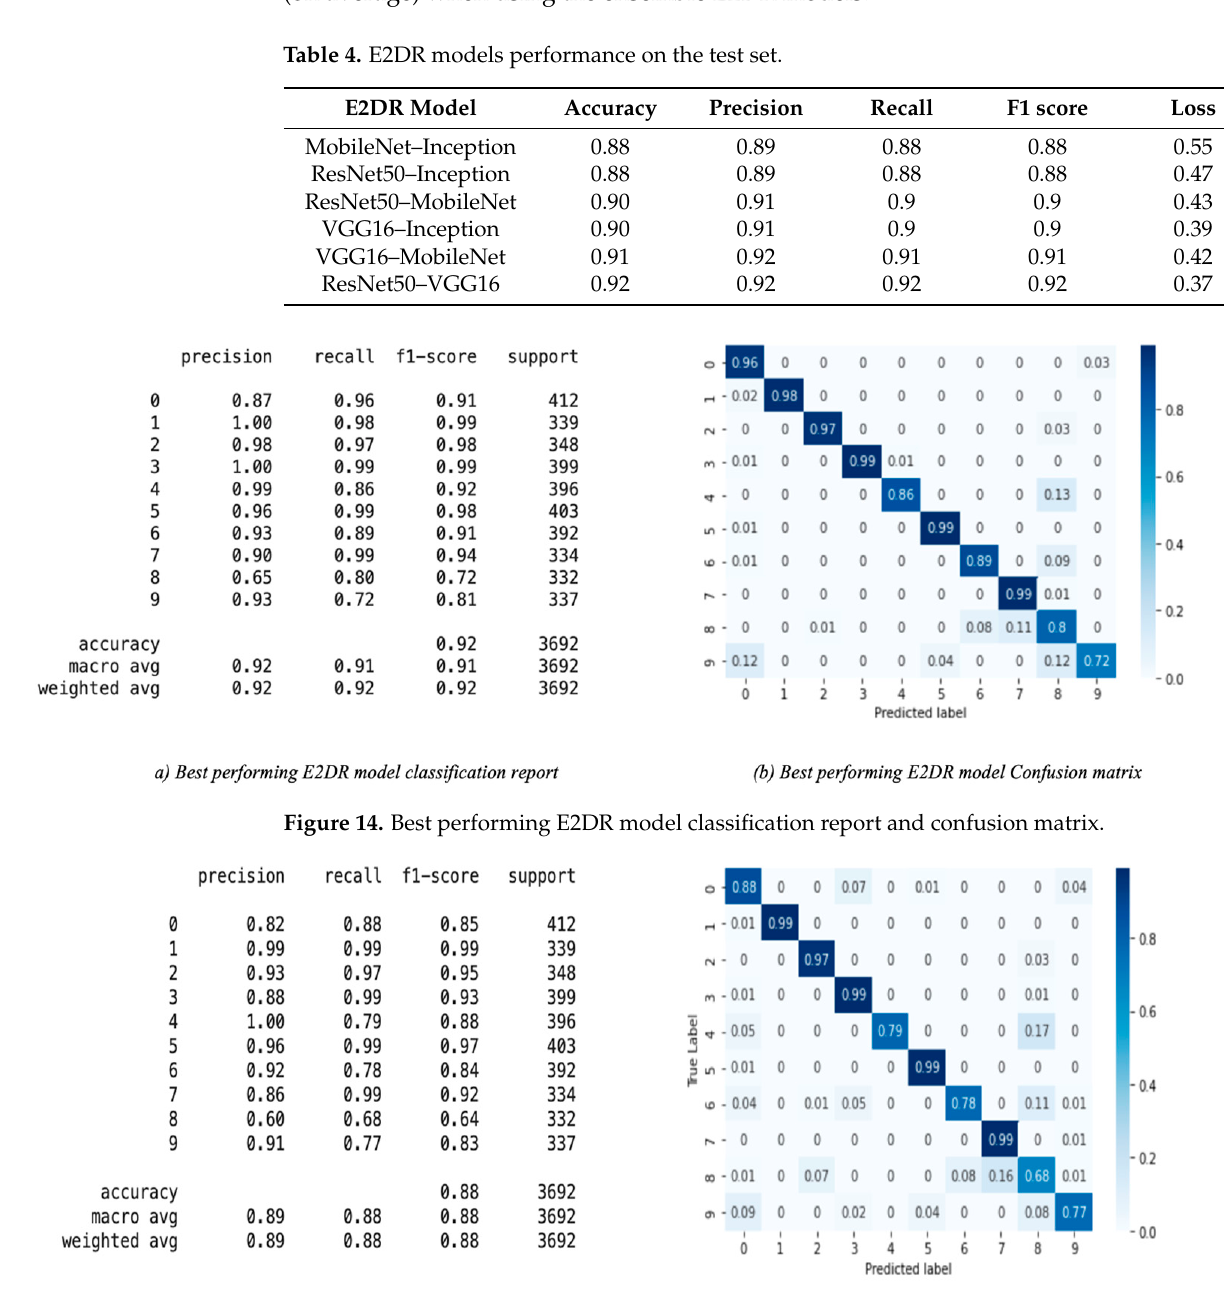
Table 4. E2DR models performance on the test set.